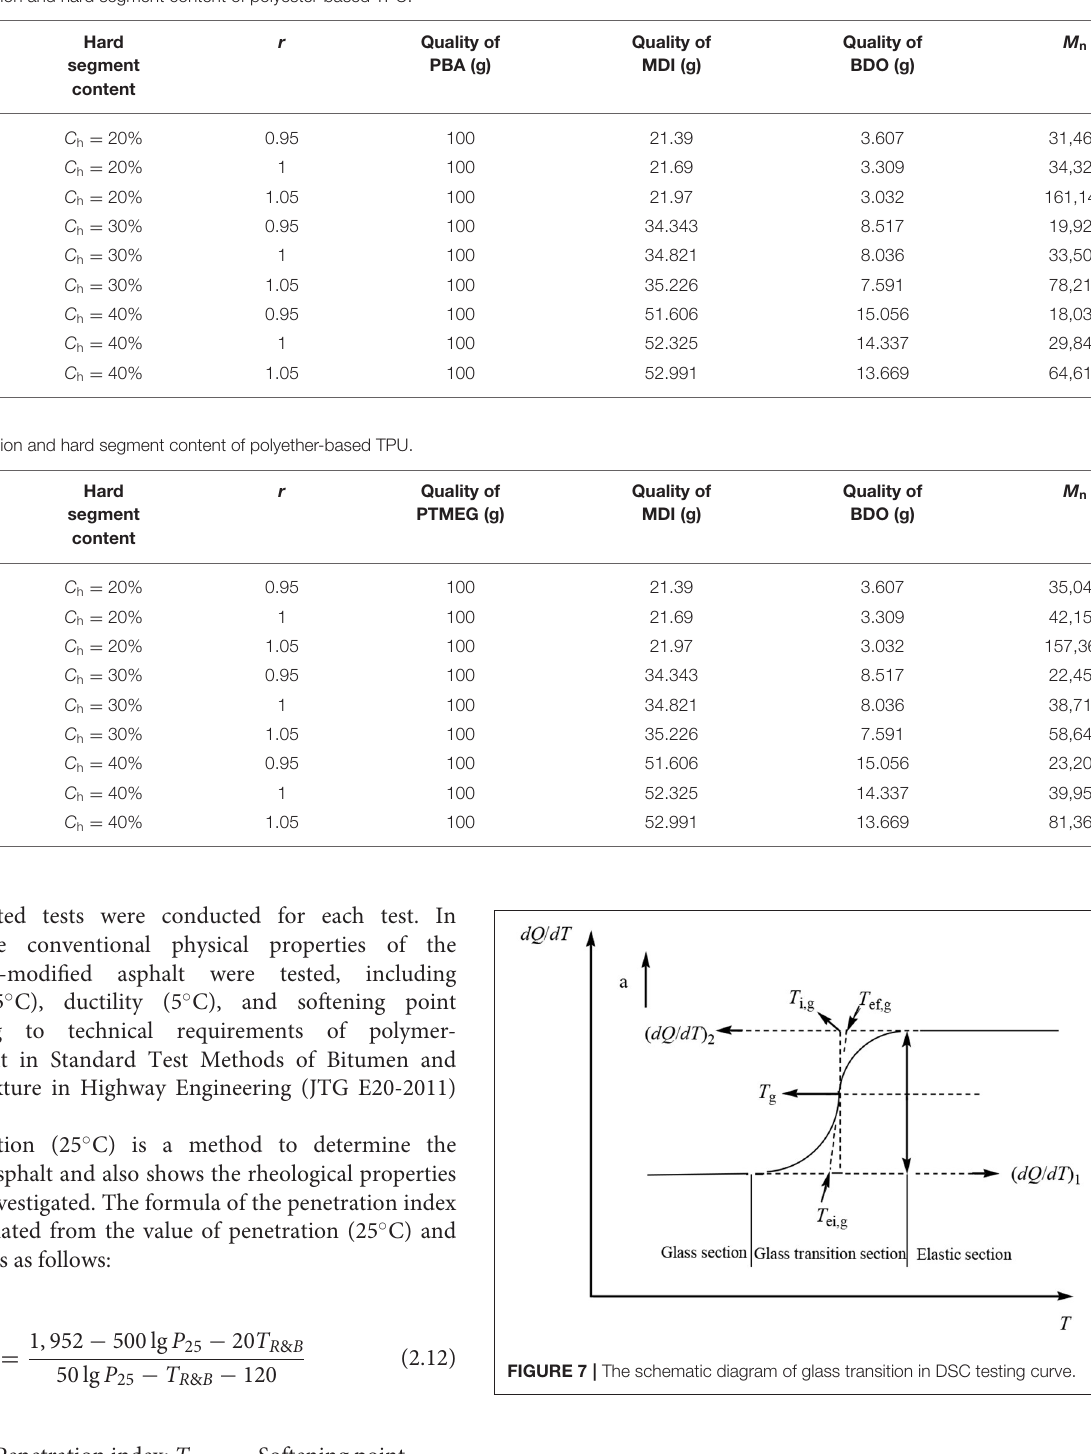
TABLE 6 | Composition and hard segment content of polyester-based TPU.